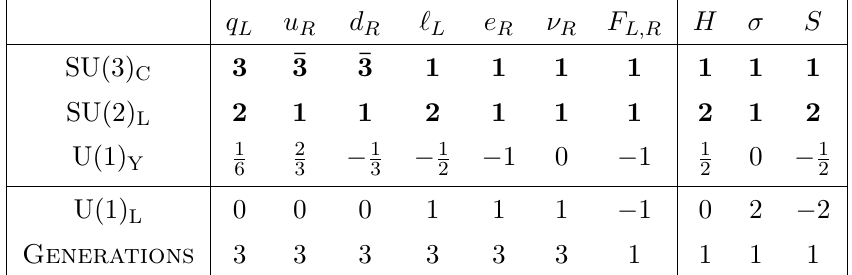
Table 1 . Particle content of the model and representations under the gauge and global symmetries. q L , ‘ L , u R , d R , e R and H are the usual SM